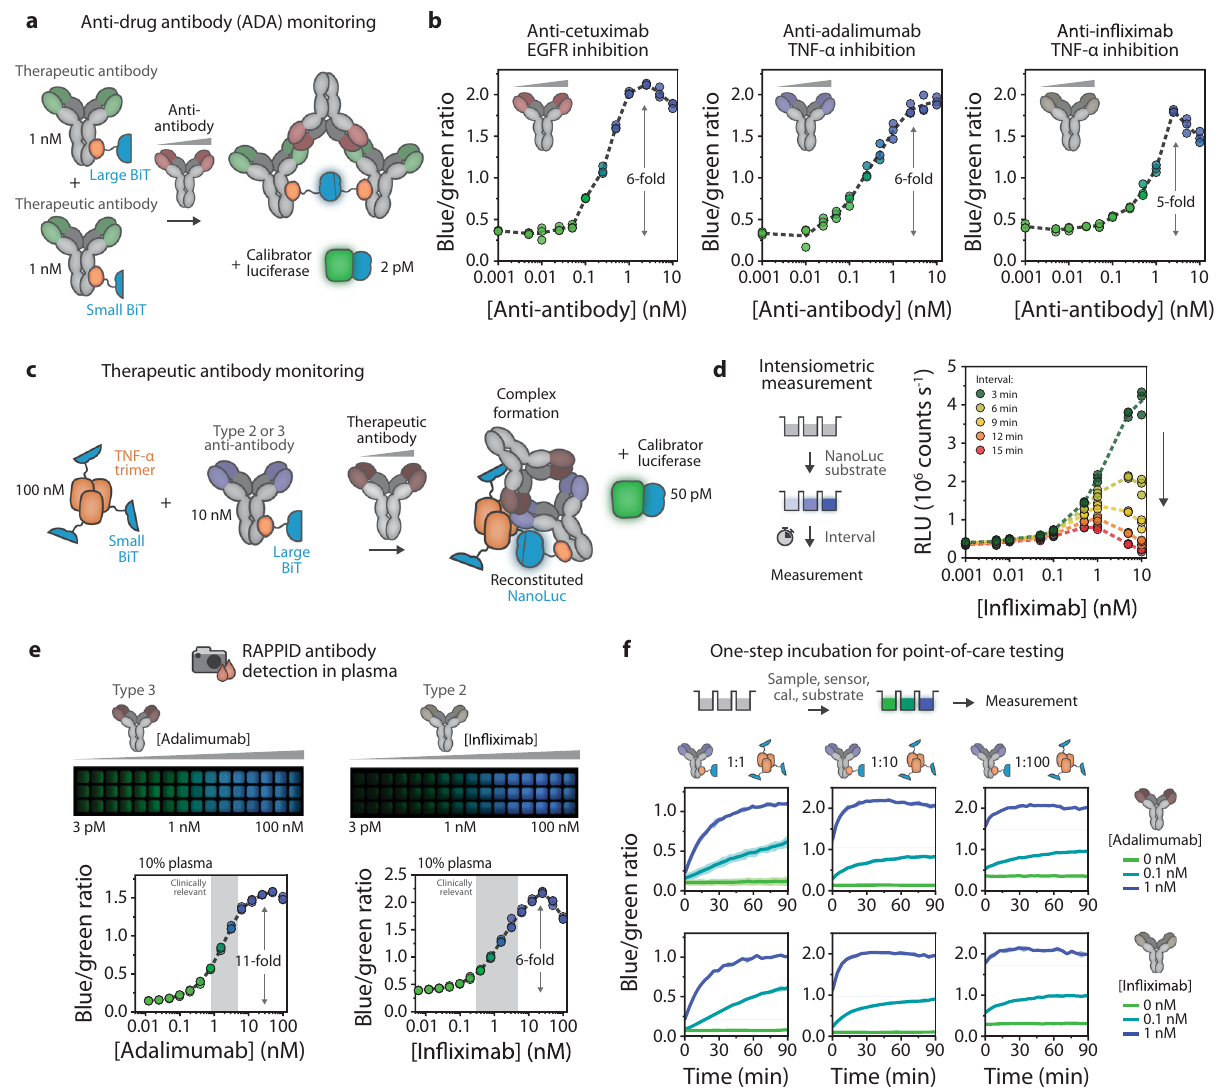
Fig. 4 RAPPID enables monitoring of clinically relevant antibodies. a Schematic overview of RAPPID sensors for the detection of anti-drug antibodies (ADAs). The use of a commercially available therapeutic antibody conjugated to both Gx-LB and Gx-SB enables binding of the ADA and the formation of a luminescent ternary complex. b Ratiometric sensor response curves in buffer (PBS (pH 7.4), 0.1% (w/v) BSA) of RAPPID sensors for anti-cetuximab, anti- adalimumab, and anti-in fl iximab, respectively. c Schematic overview of RAPPID sensors for detection of therapeutic antibodies adalimumab and in fl iximab using target antigen TNF α fused to SB, and the type 2 anti-in fl iximab and type 3 anti-adalimumab conjugated to Gx-LB. d Intensiometric detection of in fl iximab without calibrator luciferase. Luminescent measurements were performed at various intervals following the addition of the NanoLuc substrate. e Sensor response for adalimumab (left) and in fl iximab (right) detection in 10% plasma, diluted in the buffer. The same sample was used for detection with a digital camera (top) and the plate reader (bottom). Gray boxes represent the clinically relevant concentration range of each therapeutic antibody from cut- off value to trough concentration (8.5 – 53 nM and 3.3 – 47 nM for adalimumab and in fl iximab, respectively 45 – 48 ), corrected for dilution. f Sensor response over time after one-step incubation of all assay components for both adalimumab (top row) and in fl iximab detection (bottom row), with varying ratios between sensor components antibody-LB and TNF α -SB, as indicated. Antibody-LB (1 nM) and TNF α -SB (1, 10, or 100 nM), therapeutic antibody (sample; 0, 0.1, or 1 nM), calibrator luciferase (cal.; 3 – 6 pM), and NanoLuc substrate (1000 × dilutions) were added simultaneously at t = 0. In ( b ), ( d ), ( e ) individual data points are represented as circles, and dashed lines connect mean values. In ( f ) data are represented as mean ± sd. All experiments were performed in technical triplicate, with n = 3 independent preparations of the analyte. Source data are provided as a Source Data fi le. complement centralized PCR-based testing and vaccination 49 – 52 . quantitative measurements of antibodies that bind discontinuous epitopes and therapeutic antibodies and their ADAs. Two recently developed monoclonal antibodies 53 that speci fi cally target the immunogenic spike glycoprotein of the SARS-CoV-2 virus allowed us to develop RAPPID sensors for viral antigen detection. The antibodies (47D11 and 49F1) bind distinct epi- RAPPID for SARS-CoV-2 antigen and antibody detection . The topes on the spike protein which natively exists as a trimer. We modularity of the RAPPID platform is also attractive for the rapid constructed two sensor variants, using either both antibodies development of sensors for newly emerging targets. The COVID- (heteropair, 47D11-LB with 49F1-SB) or only a single antibody 19 pandemic, caused by the SARS-CoV-2 virus, has highlighted (homopair, 47D11-LB with 47D11-SB) and directly utilized them the need for fast, low-cost, point-of-care viral detection to NATURE COMMUNICATIONS| (2021) 12:4586